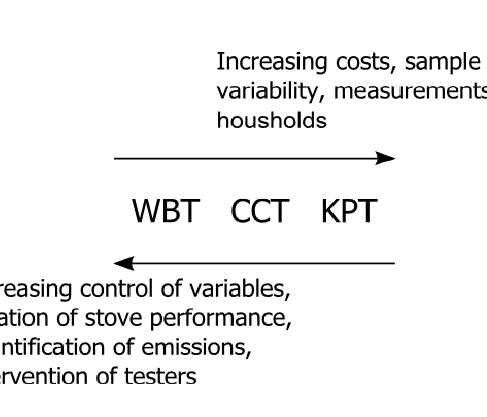
Figure 3. Relative benefits and trade-offs of biomass use quantification